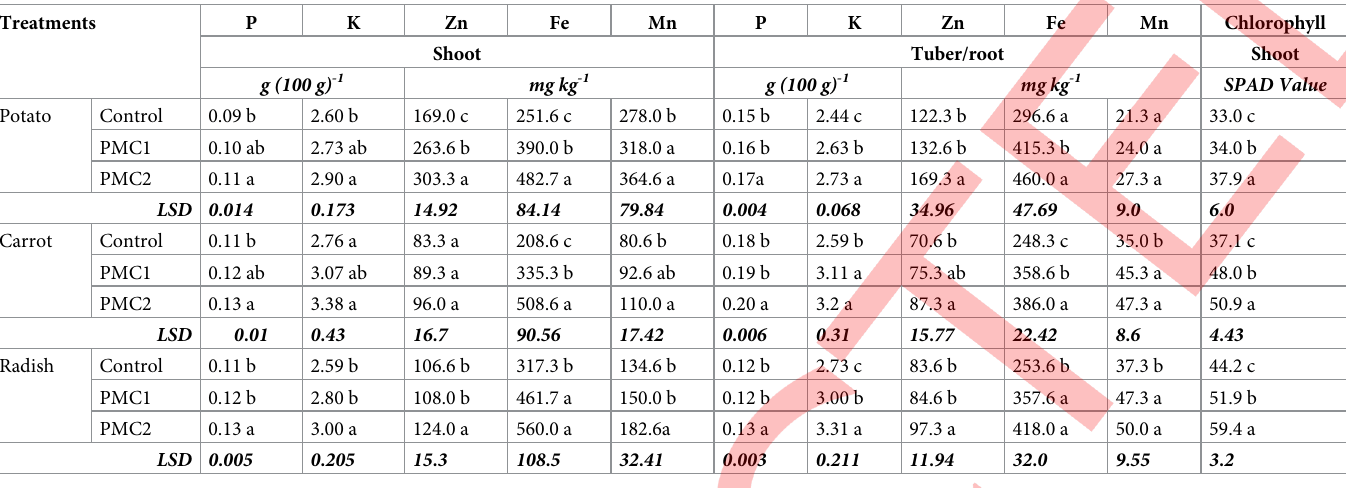
Table 2. Effect of poultry mortality compost on phosphorus, potassium, zinc, iron, manganese and chlorophyll contents in potato, carrot and radish. Three levels of compost: 0 (Control), 1250 kg compost ha -1 (PMC1) and 1850 kg compost ha -1 (PMC2). Treatments